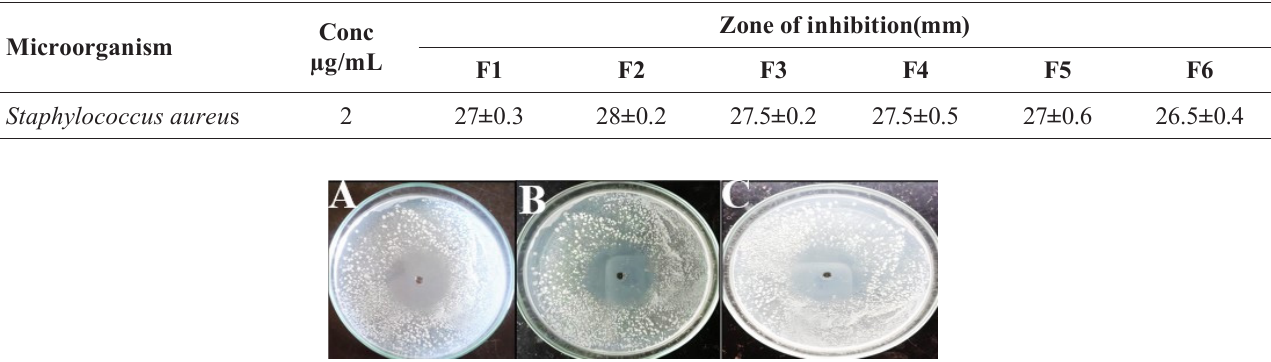
FIGURE 3 - (A)- Zone of inhibition of F2 formulation. (B) - Zone of inhibition of F4 formulation. (C) - Zone of inhibition of F6